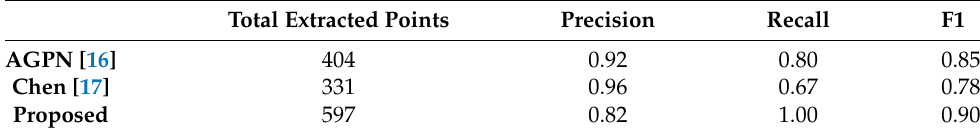
Table 8. Comparing results on the cube